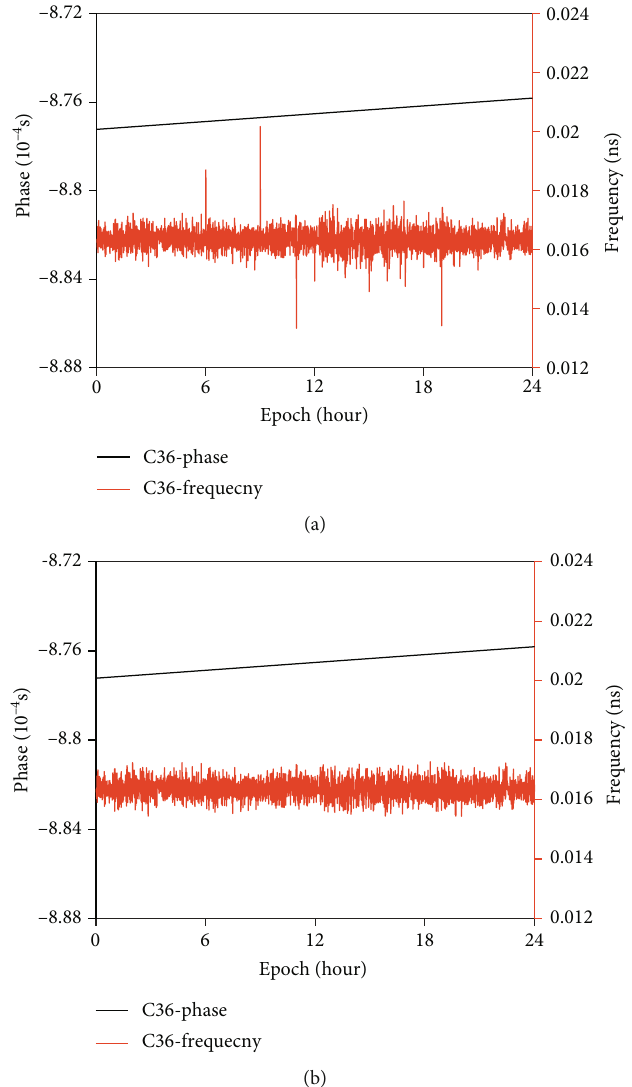
Figure 5: The combined gross error detection method. (a) The black line represents the phase data of the original clock o ff set, and the red line represents the frequency data of the original clock o ff set. (b) The black and red lines represent the phase and frequency data after correction by the gross error detection method,